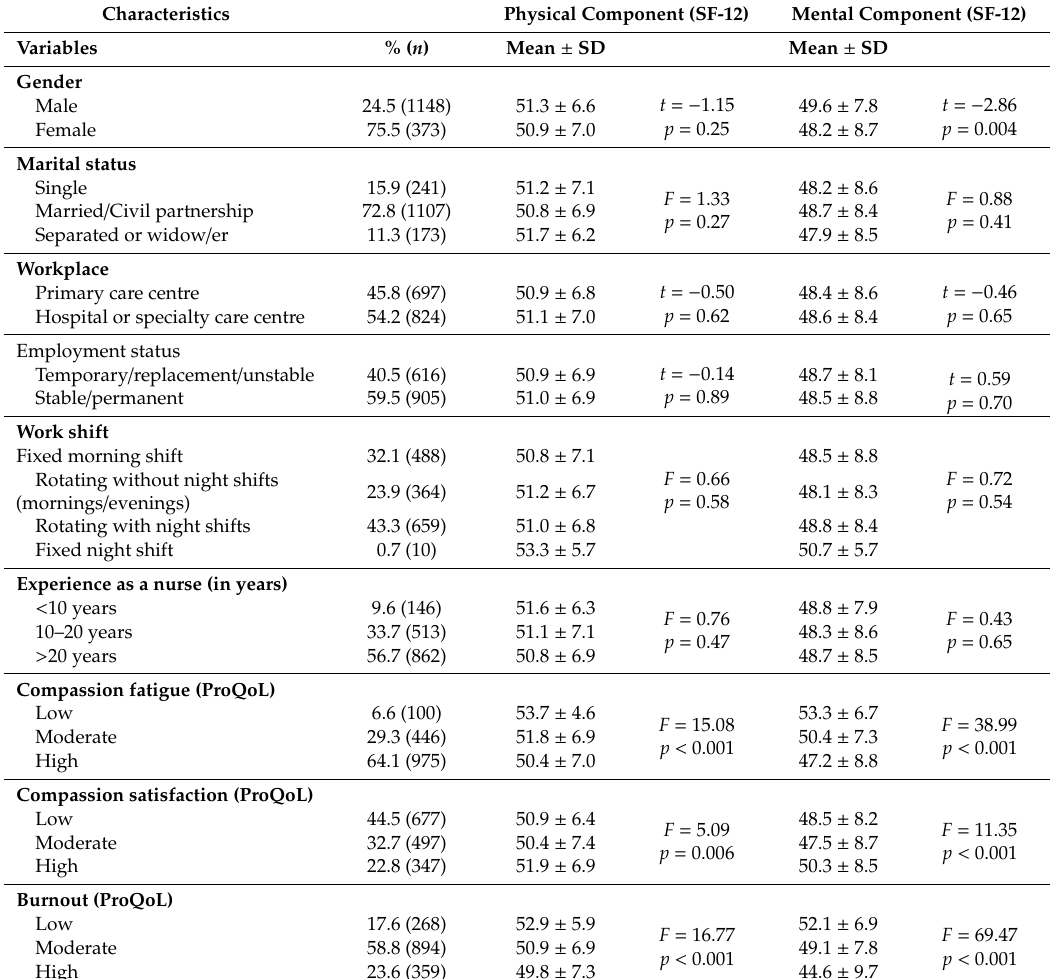
Table 2. Di ff erences in means in HRQoL scores according to sociodemographic and work-related variables of the nurses ( n =